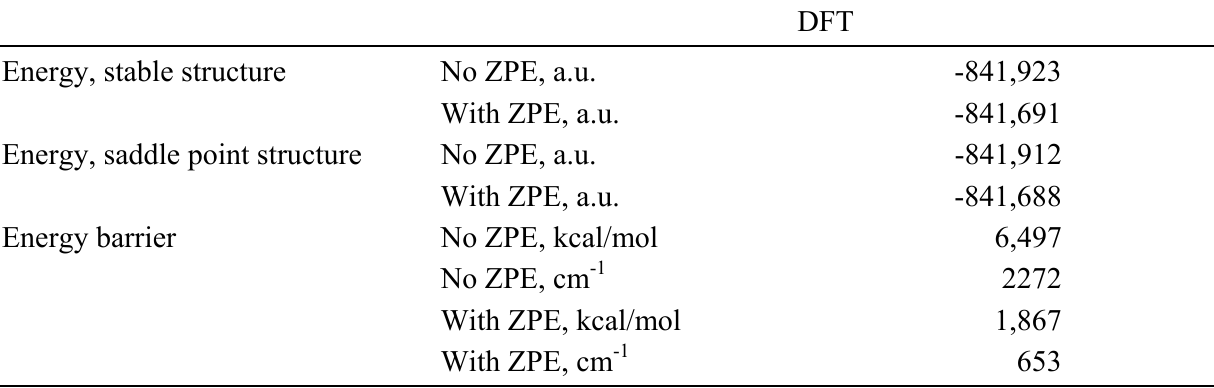
Table 3. Calculated energies and barrier for benzoic acid by the B3LYP/6-311++G** (DFT) method. DFT Energy, stable structure No ZPE, a.u. With ZPE, a.u. Energy, saddle point structure No ZPE, a.u. Energy